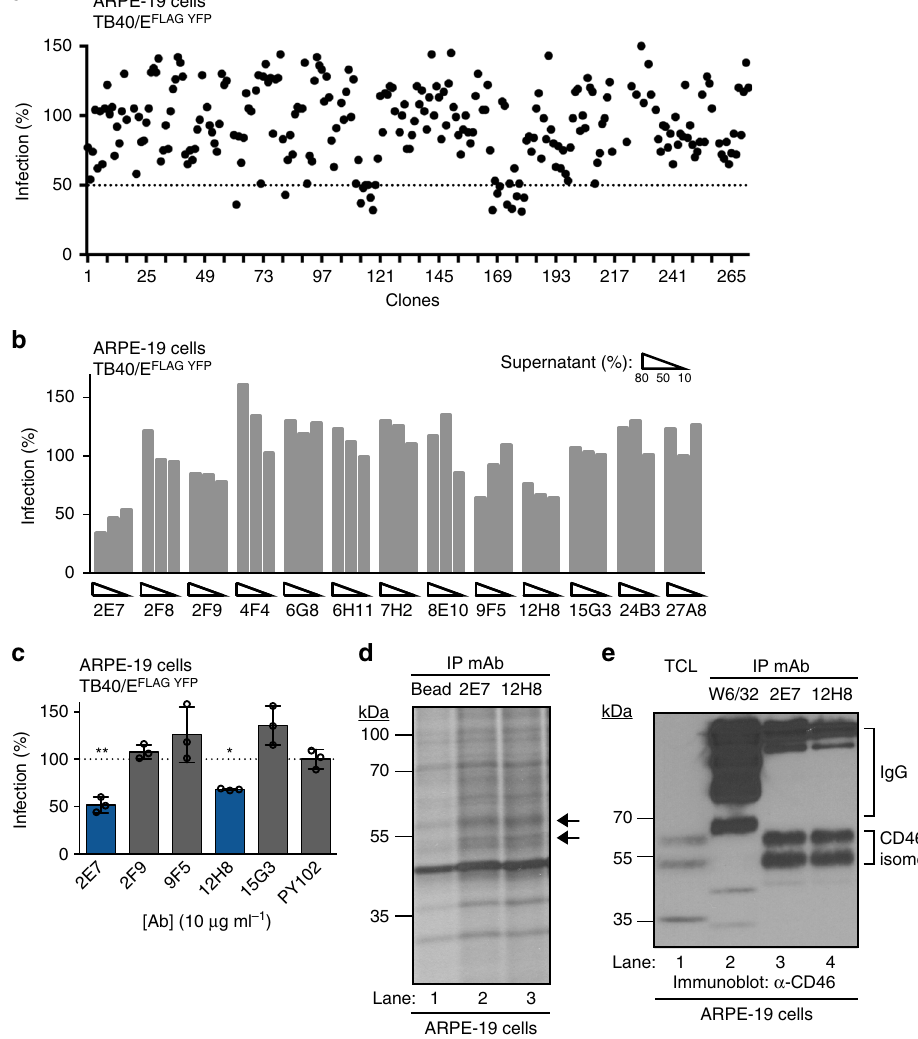
Fig. 3 Identi fi cation of inhibitory monoclonal antibodies and their cellular target. a Supernatants from cell-surface binding clones were subjected to a high- throughput infectivity assay (HTI) with TB40/E FLAG YFP infection of ARPE-19 cells using YFP fl uorescence as readout for infection. The % infection was determined using virus incubated with media alone as 100%. b Clones demonstrating reduced infection were validated using the TB40/E FLAGYFP /ARPE-19 cells HTI with varying amounts (%) of supernatant. c Puri fi ed mAbs (10 μ g ml − 1 ) were analyzed using the TB40/E FLAG YFP /ARPE-19 HTI in technical triplicates. d Polypeptides recovered with mAb 2E7 and 12H8 (arrows) from ARPE-19 cells metabolically labeled with 35 S-methinionine (6 h) were resolved on a SDS-polyacrylamide gel and visualized on a radiographic fi lm. Beads only was used as a control. e Polypeptides recovered with mAb 2E7 and 12H8 from ARPE-19 cells were subjected to immunoblot analysis using anti-CD46 antibodies. mAb W6/32 and total cell lysates (TCL) were included as controls. The polypeptides and molecular weight markers are indicated. s.d. is depicted in the experiment. * P < 0.05, ** P < 0.01 (Student ’ s two-tailed t